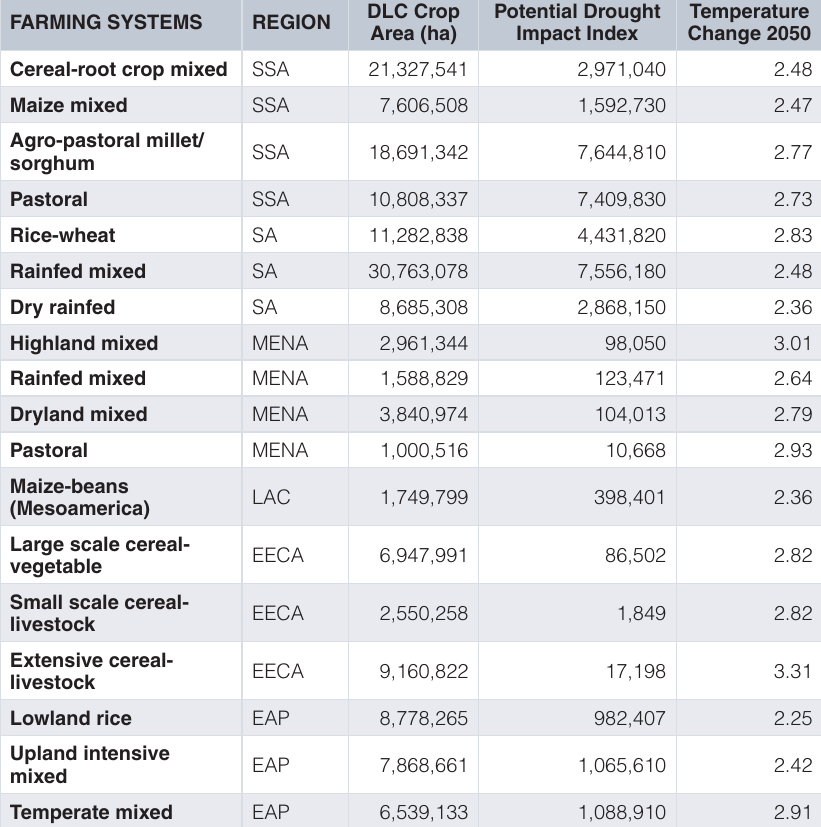
Table 5. The farming systems where dryland cereals and grain legumes are concentrated are particularly prone to high temperatures and drought.